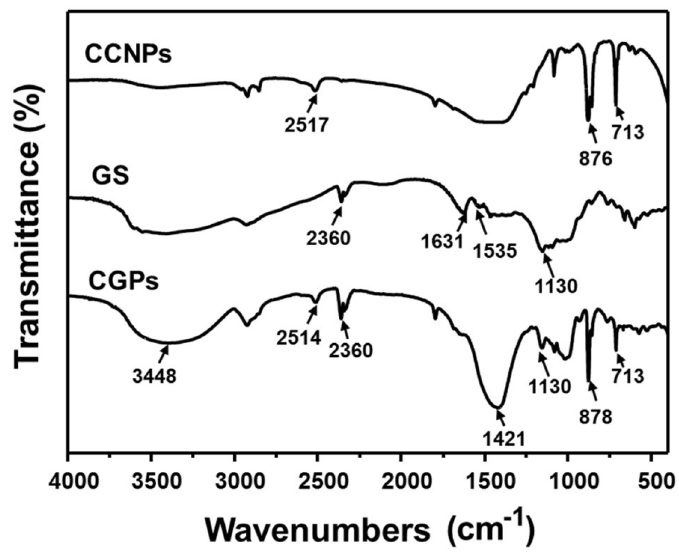
Figure 15. FTIR spectra of CCNPs, GS, and CGPs [68] . Adapted with permission from ref. [68] . A 2018 Creative Commons Attribution (CC BY) license.